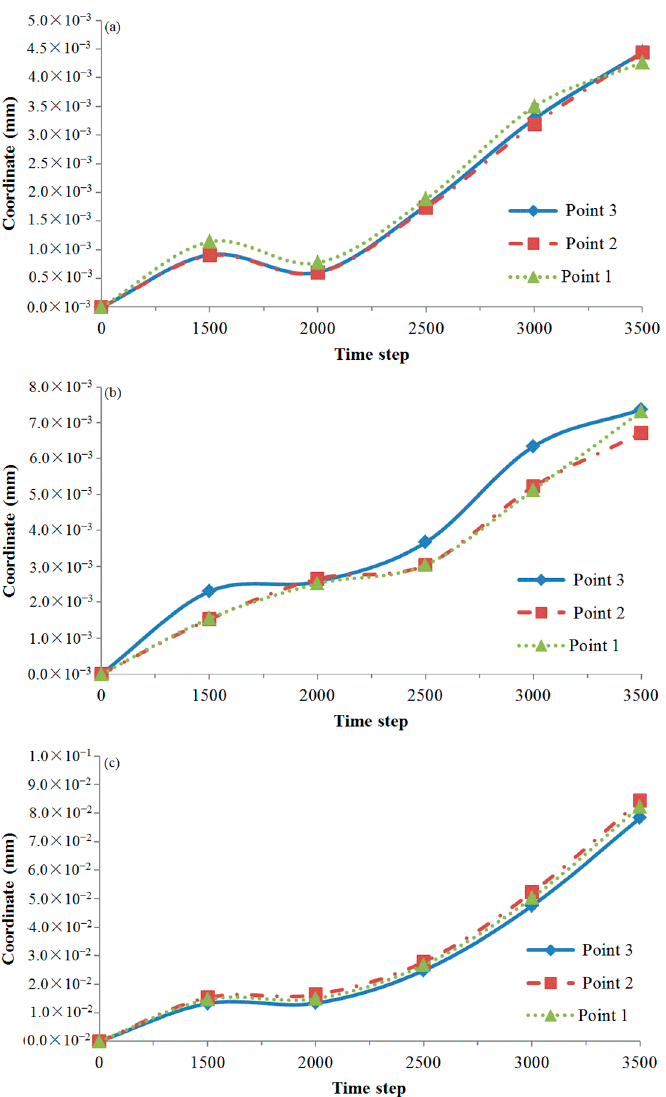
Figure 11. Displacement changing with the time of material points marked in the near-field of the cutting edge: ( a ) feed direction, ( b ) cutting depth direction and ( c ) main cutting direction.